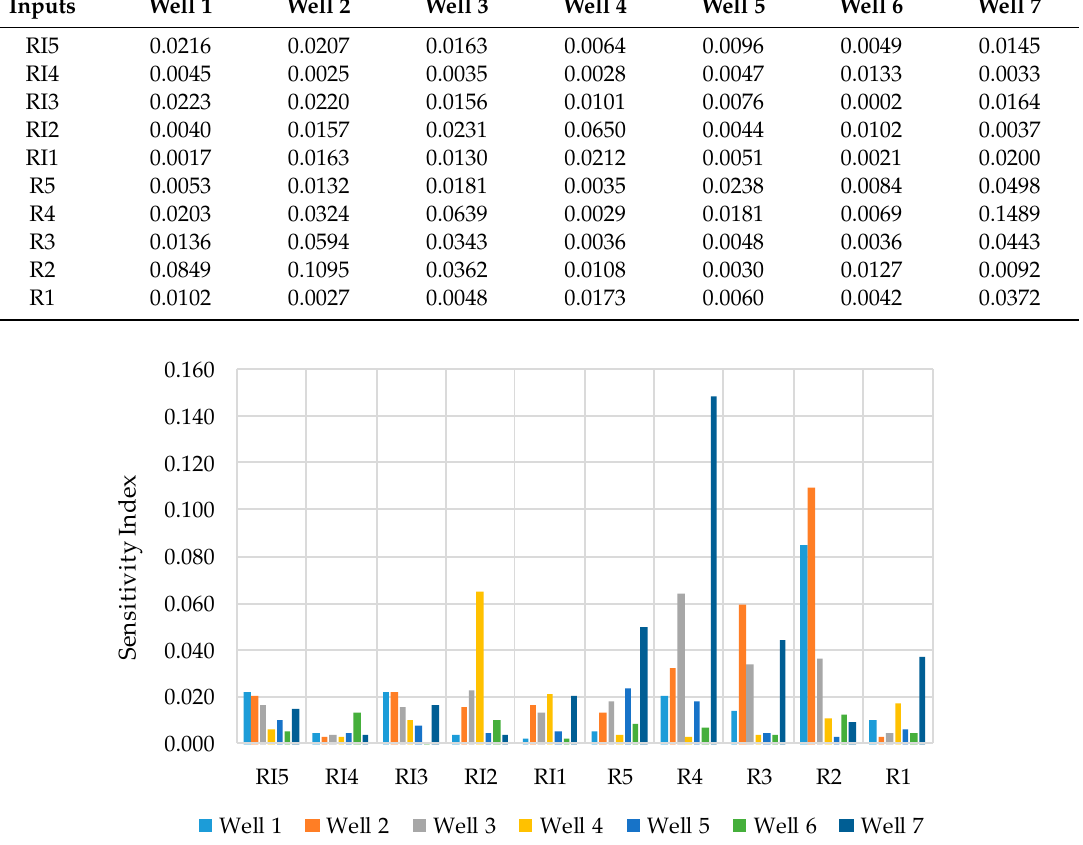
Table 4. Sensitivity analysis index.